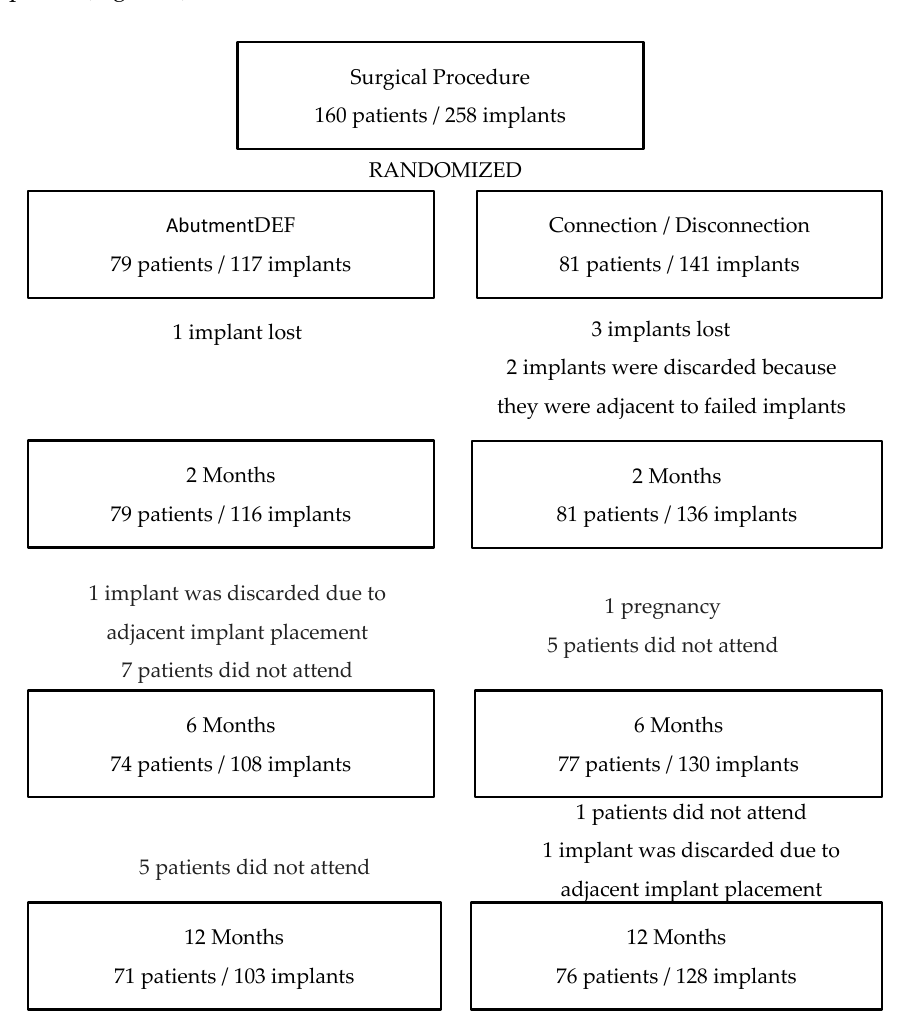
Figure 4. Population Diagram.